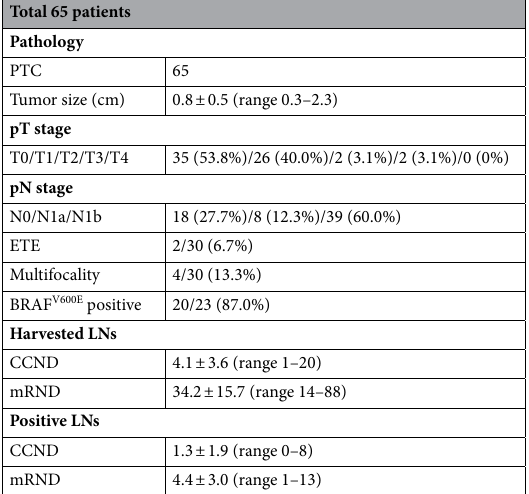
Table 2. Baseline pathological characteristics of re-do robotic operation. Data are expressed as patient number (%) or mean ± SD. PTC papillary thyroid carcinoma, T tumor, N node, ETE extra-thyroidal extension, LN lymph node, CCND central compartment neck node dissection, mRND modified radical neck